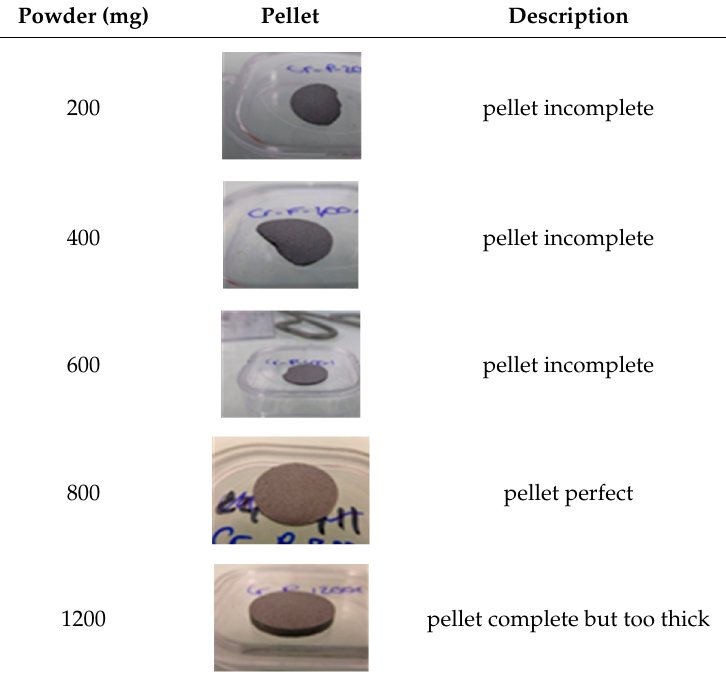
Table 5. Various mass of pellet of Cr.